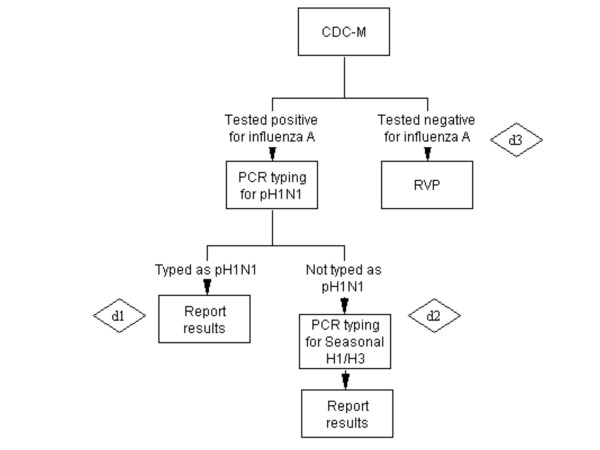
Scenario D - CDC-M only.